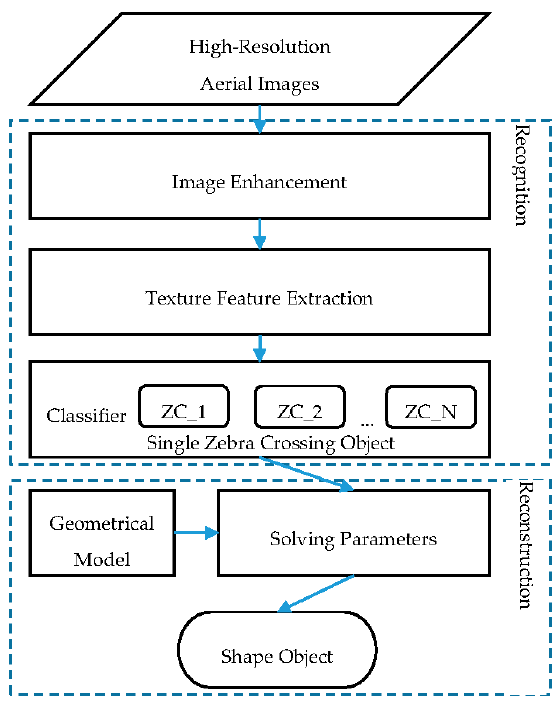
Figure 1. The workflow of the proposed method.